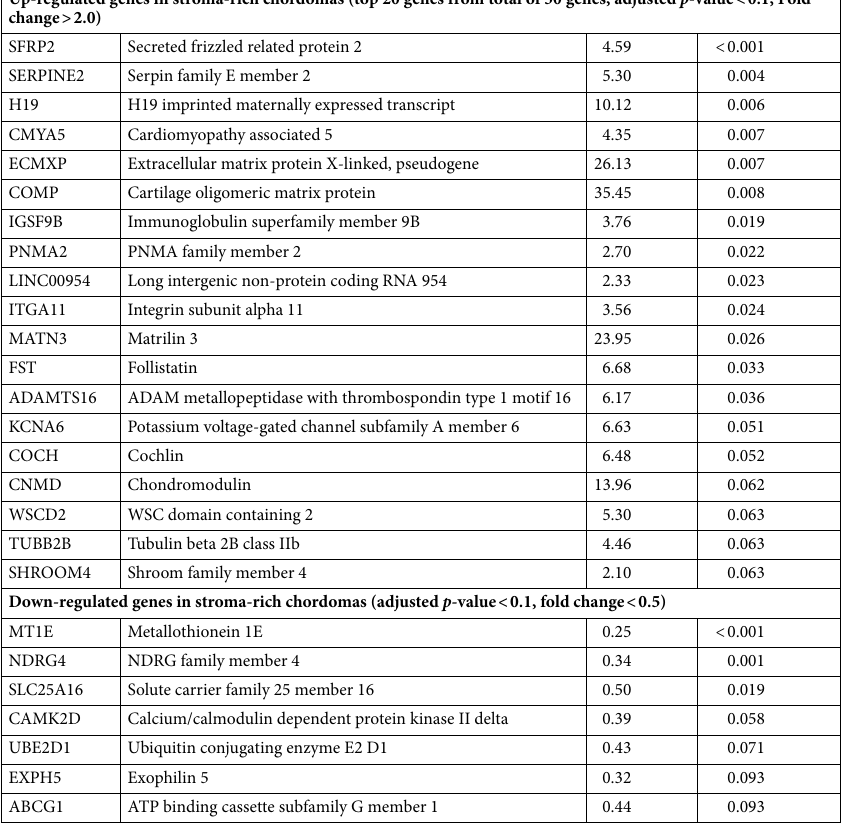
Table 2. Differentially expressed genes according to the stromal component of chordomas.